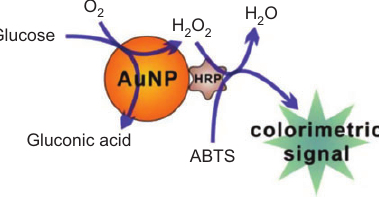
Figure 9 Schematic showing HRP-AuNPs catalyzing the glucose involved cascade reaction [105]